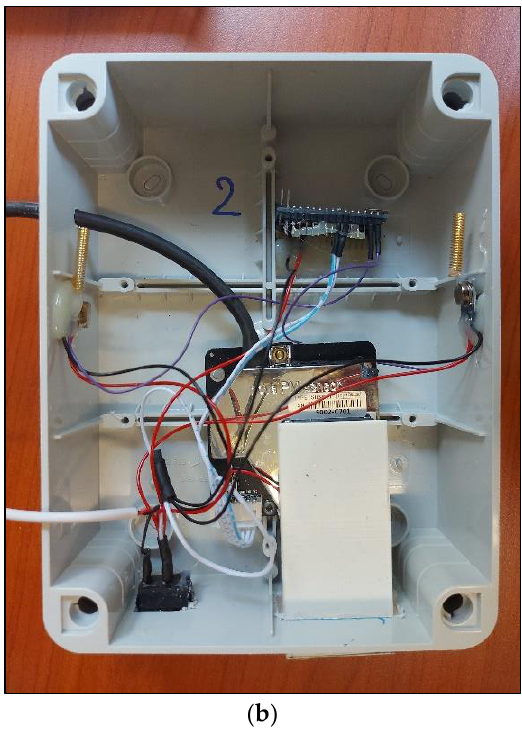
Figure 6. ( a ) Data logger scheme, ( b ) data logger photo.